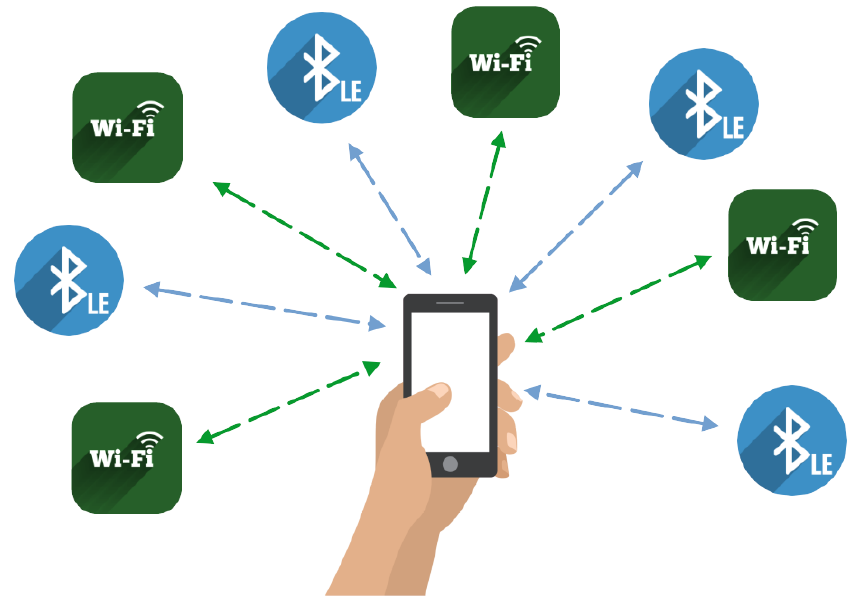
Figure 1. Project data transmission layout.